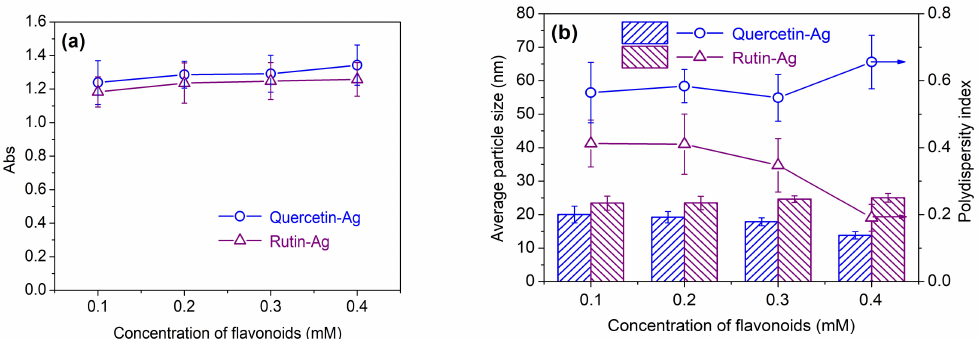
Figure 3. Absorbance ( a ) and average particle size ( b ) of the AgNPs synthesized using various concentrations of flavonoids.